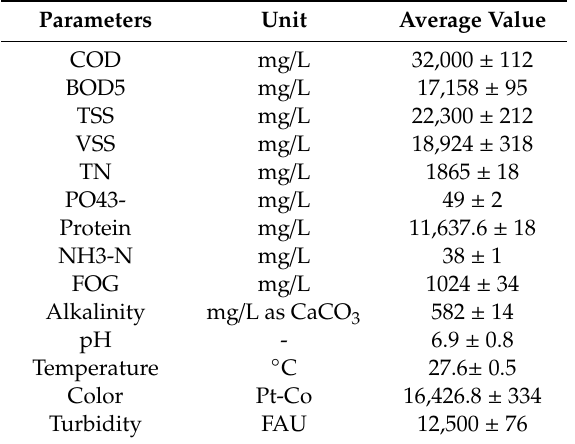
Table 1. Characteristics of the cattle slaughterhouse wastewater (CSWW). COD = chemical oxygen demand; TSS = total suspended solids; VSS = volatile suspended solids; FOG = fats, oil, and grease.